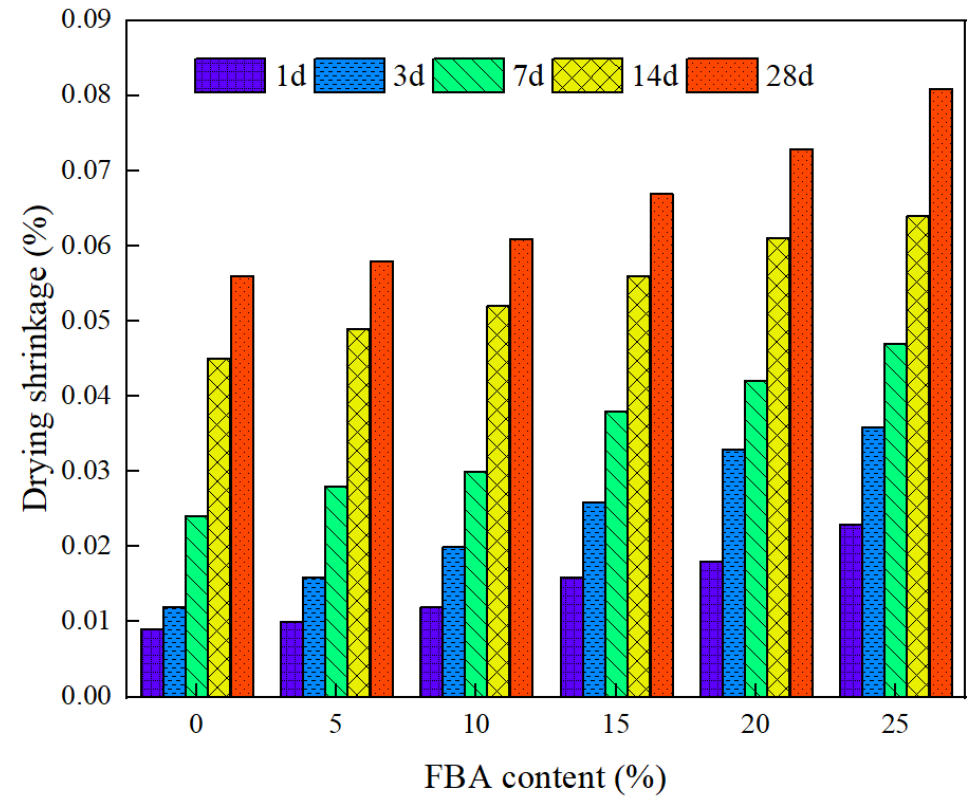
Figure 10. The results of drying shrinkage of MPC mortars with different FBA content.